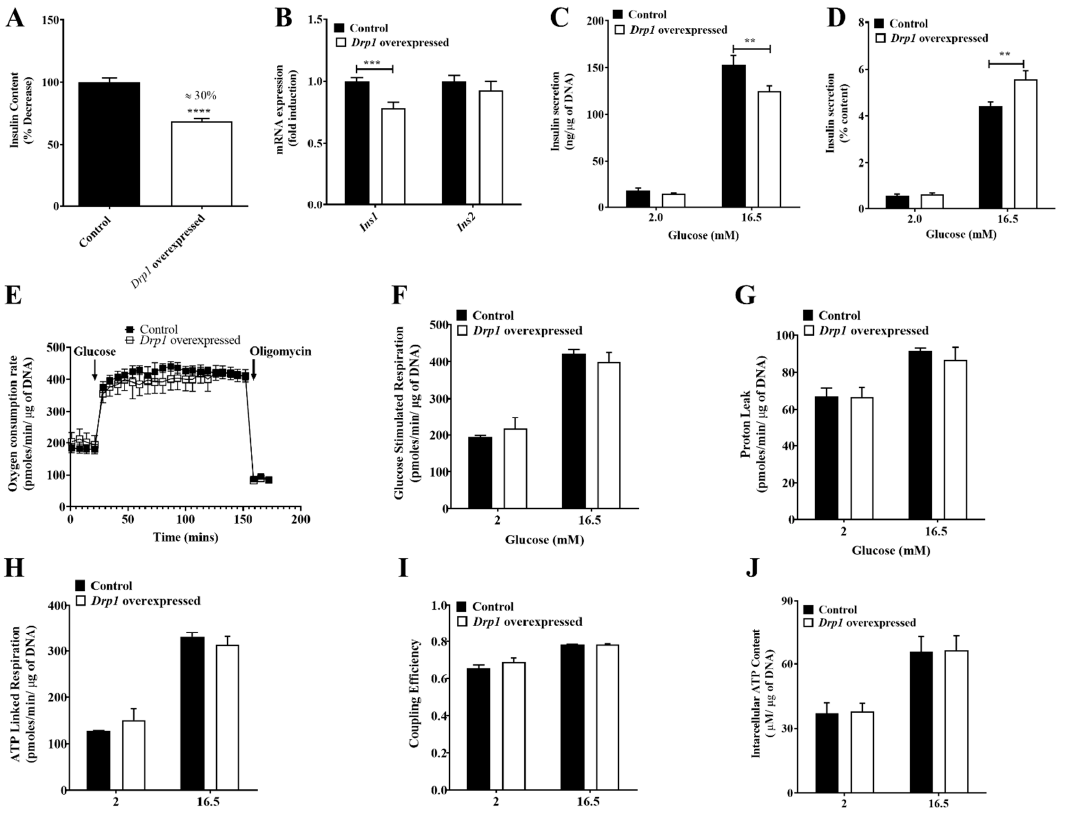
Figure 3. Insulin content and GSIS of Drp1 -overexpressed MIN6 cells. MIN6 cells were transiently transfected with the Drp1 plasmid by the electroporation technique to overexpress Drp1; control (black bars) and overexpressed Drp1 (white bars). ( A ) Insulin content expressed as a % decrease. ( B ) Relative levels of Ins1 and Ins2 mRNA were measured by qPCR. HPRT was used as a control. Data are represented as mean ± SEM ( n = 3). ( C ) Insulin release is expressed as nanograms per microgram of DNA. ( D ) Insulin release is expressed as a percentage of content. Data are represented as mean ± SEM ( n = 4). ( E ) Averaged, time-resolved oxygen consumption traces measured with the XF24 ex- tracellular flux analyzer. ( F ) Mitochondrial respiration. ( G ) Proton leak respiration. ( H ) ATP-linked respiration. ( I ) Coupling efficiency. Data are represented as mean ± SEM ( n = 3). ( J ) Intracellular ATP content. Data are represented as mean ± SEM ( n = 4), and n -values represent independent experi- ments. The statistical significance of mean differences was tested by an unpaired two-tailed Stu- dent’s t -test to compare two variables. p < 0.01 (**), p < 0.001 (***), p < 0.0001 (****).